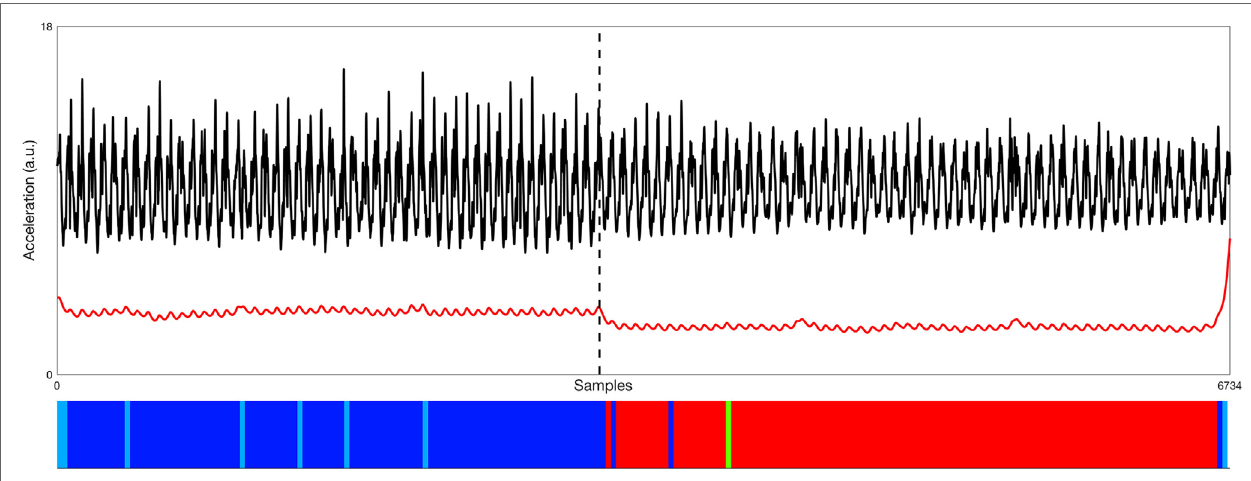
FiGUre 2 | Representative example of data processed from the accelerometer (black signal—raw vertical acceleration; red signal—low-pass filtered posterior– anterior acceleration) used by one of the six Parkinson’s disease (PD) patients during two 10-m walk trials, first in his OFF state and later in his best ON state. Time series are two collated non-consecutive segments of data recorded OFF (left) and best ON (right) states of one PD patient, as indicated by the black dashed line. Bottom: the distinction between the OFF and ON states is very clear with this methodology, where the clusters’ organization (showed by the color bar) perfectly aligns with the transition of the signals above. Different colors represent found behavioral blocks (same color code as Figure 1B